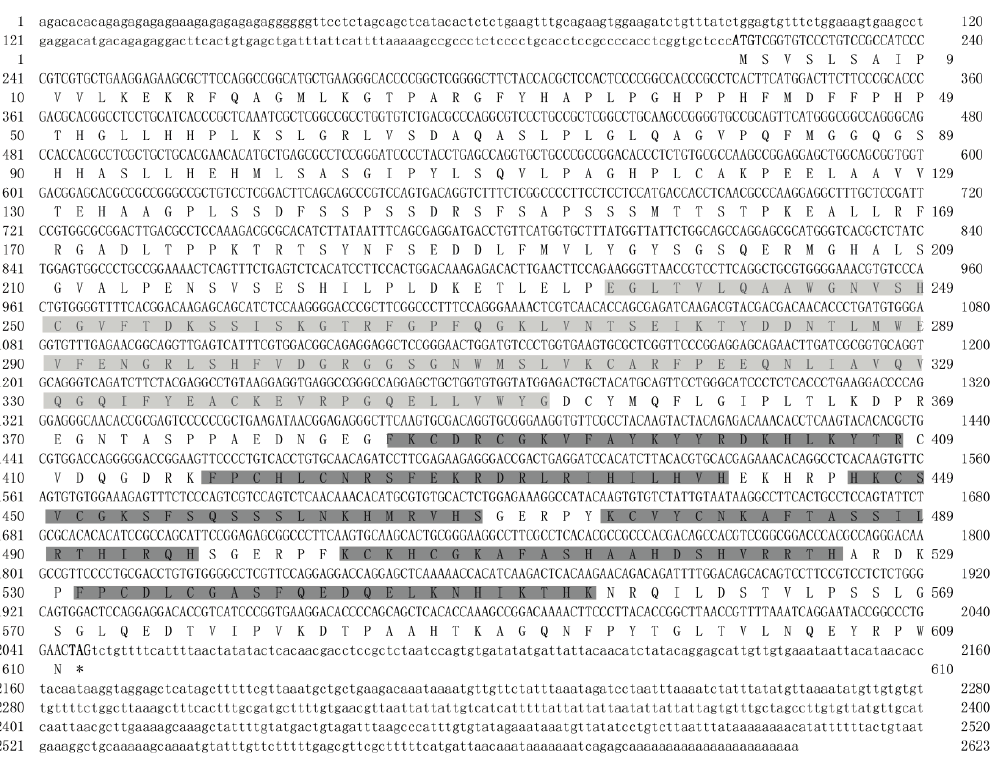
Figure 1. Nucleotide and deduced amino acid sequences of Po- PRDM14. The open reading frame (ORF) is denoted in uppercase letters, and the untranslated regions (UTRs) are denoted in lowercase. The deduced amino acids are indicated in the one-letter code and presented below the coding regions. The start and termination codons are highlighted in boldface. The SET domain and the six zinc fingers are shaded with light and dark gray boxes, respectively.